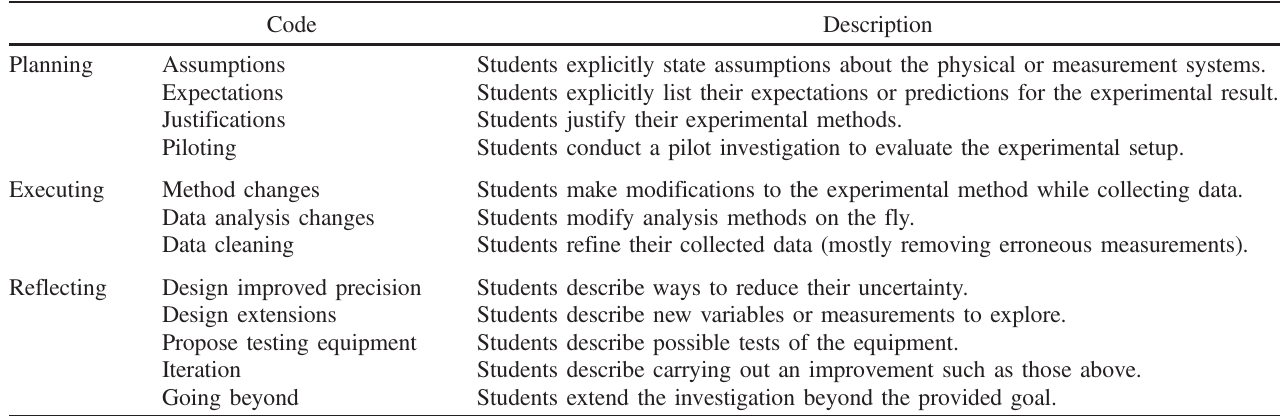
TABLE III. Emergent codes indicating students ’ decisions and